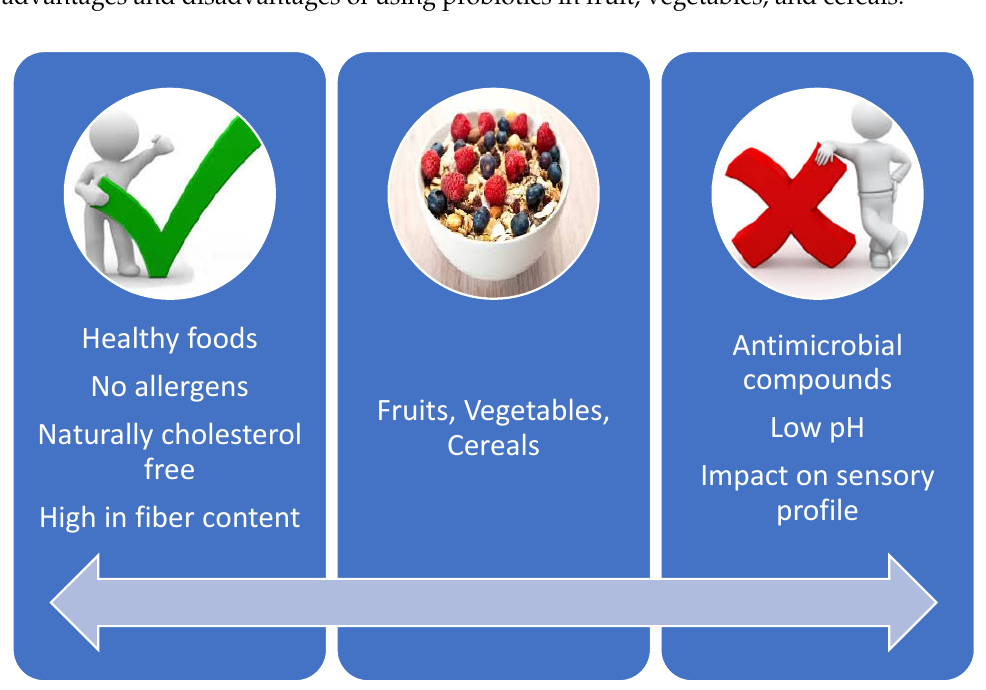
Figure 3. Advantages and disadvantages of using probiotics, fruits, vegetables, and cereals .